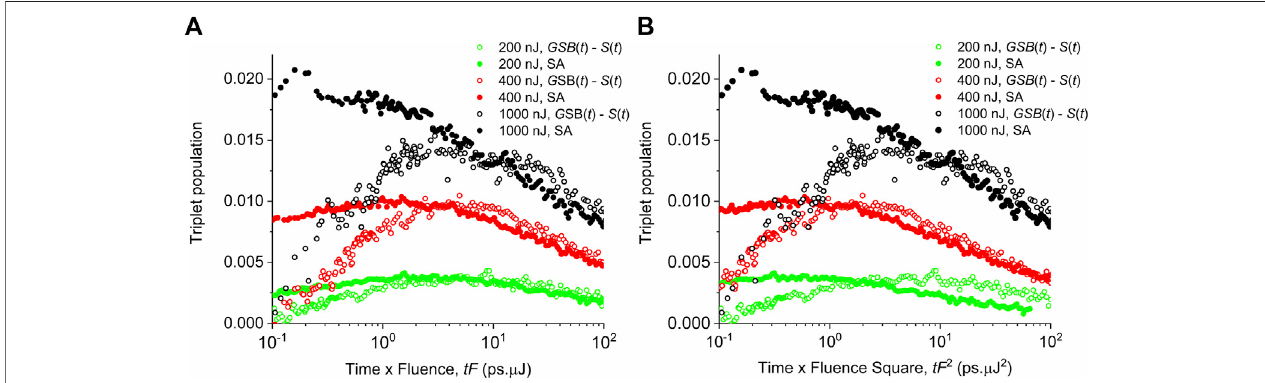
FIGURE 8 | Experimental data of the triplet exciton population evolution for different pump fl uences F shown in the legend. Empty symbols — data obtained by subtractingtheground-statebleachandthesingletpopulations.Fullsymbols — datafromthespectralanalysis(SA)oftransientabsorptionreportedbyRaisetal.,2017b. In x -axis, time is rescaled as tF (A) , and tF 2 (B) .